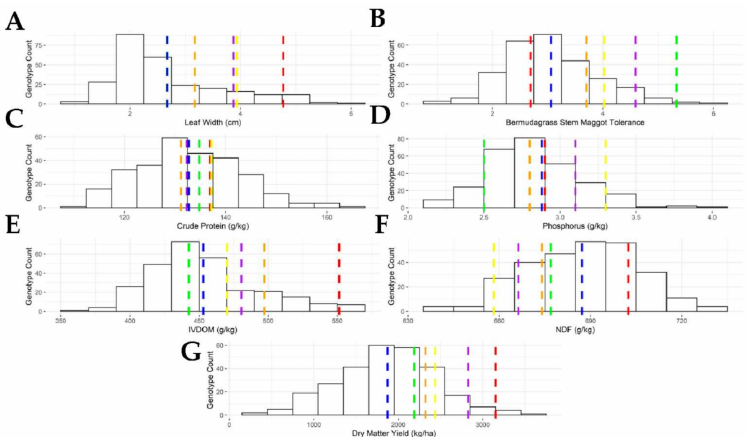
Figure 5. Histogram for five traits using predictive values estimated for the USDA-NPGS bermuda- grass germplasm collection and five checks: Tifton 85 (red), Mislevy (green), Florida 44 (orange), Jiggs (purple), and Coastal (yellow). Traits: ( A ) leaf width (cm), ( B ) Bermudagrass Stem Maggot tolerance (1 = 10 percent or less damage, 9 = 90 percent or more damage), and the following nutritive value traits expressed in g kg − 1 : ( C ) crude protein, ( D ) in vitro organic matter digestibility (IVDOM), ( E ) nutrient detergent fiber (NDF), and ( F ) phosphorus, and ( G ) dry matter yield (kg ha − 1 ). The dashed colored lines represent the means for each check, and the blue lines represents the population